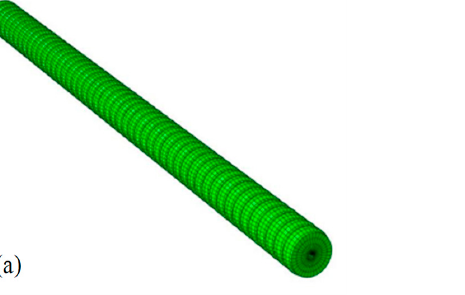
Figure 8. Network division of GFRP anchorage model: ( a ) GFPR anchor bolt, ( b ) anchorage system.